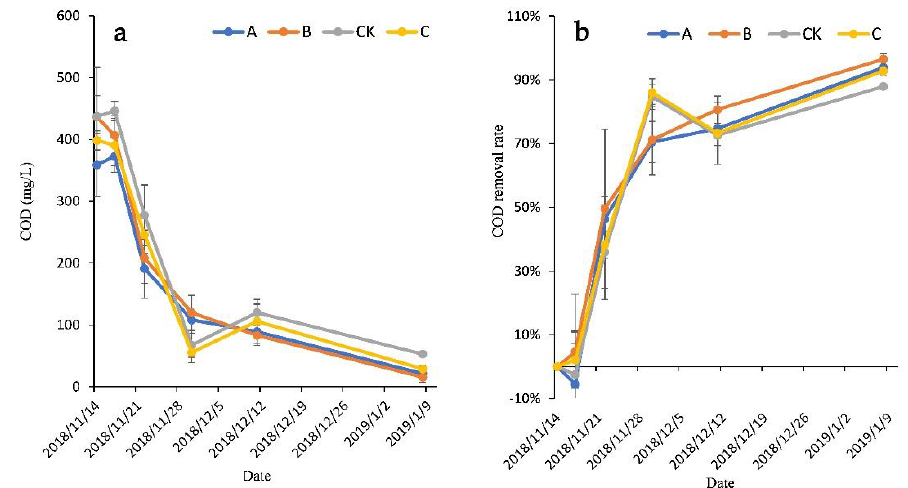
Figure 4. Variation in the ( a ) COD concentration and ( b ) removal rate of each treatment.